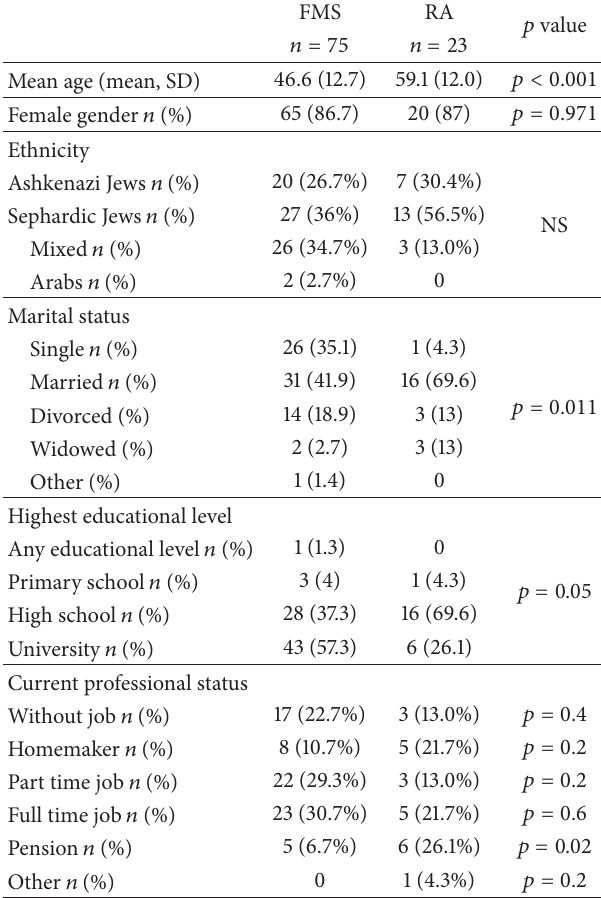
Table 1: Comparison of demographic data of Israeli patients with FMS ( 𝑛 = 75 ) and RA ( 𝑛 = 23